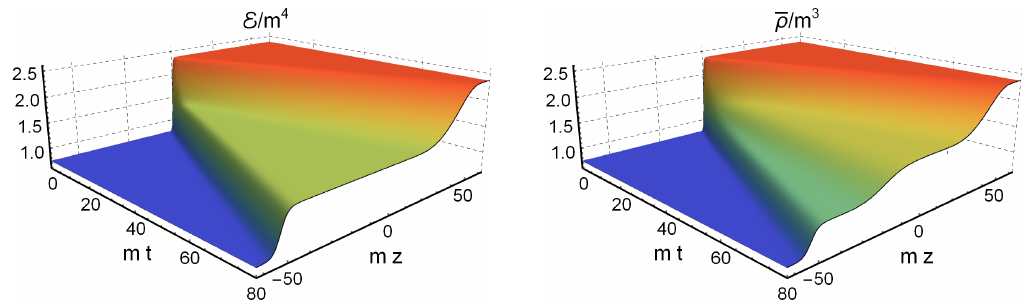
Figure 5: Time evolution of the energy density (left) and charge density (right) for χ = 9 / 16 and n / n = χ 2 . A steady state region forms between the shock (moving C H towards the cold bath) and the rarefaction wave (moving towards the hot bath). Two regions with constant charge density can be identified within the steady state